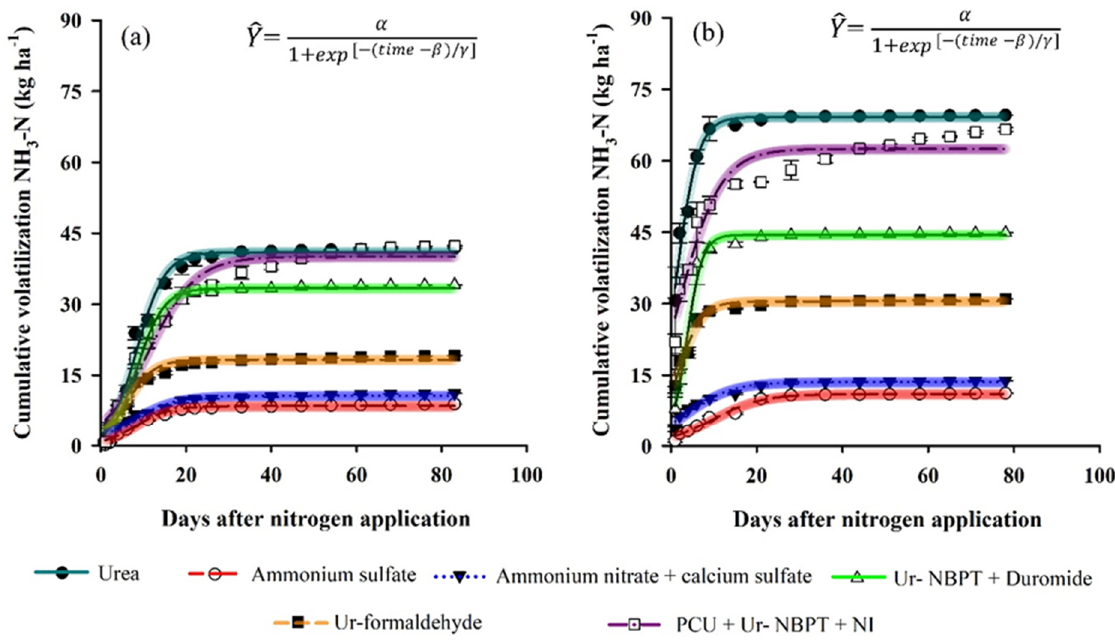
Figure 4. Cumulative volatilization of NH3-N after topdressing applications of urea, ammonium sulfate, ammonium nitrate + calcium sulfate, Ur-NBPT + Duromide, Ur-formaldehyde, and PCU + Ur-NBPT + NI for clayey soil at a rate of 200 kg ha − 1 of N ( a ) and for sand soil at a rate of 150 kg ha − 1 of N ( b ). Data with overlapping vertical bars with 95% confidence interval in the curve.